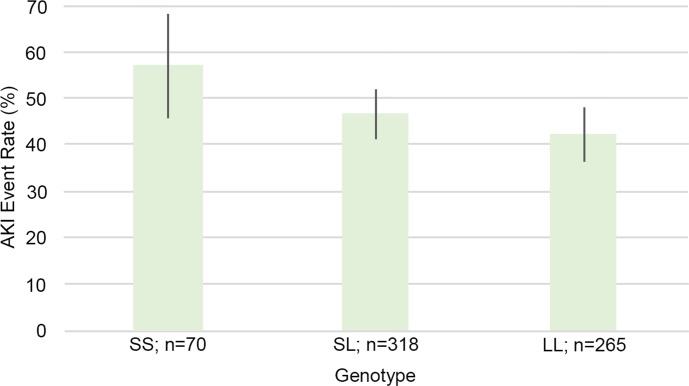
Acute kidney injury (AKI) event rate according to genotype (SS, SL, or LL).